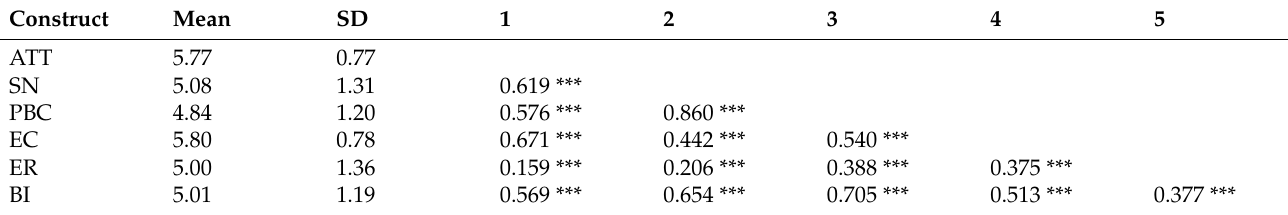
Table 2. Mean, standard deviation (SD), and correlations of